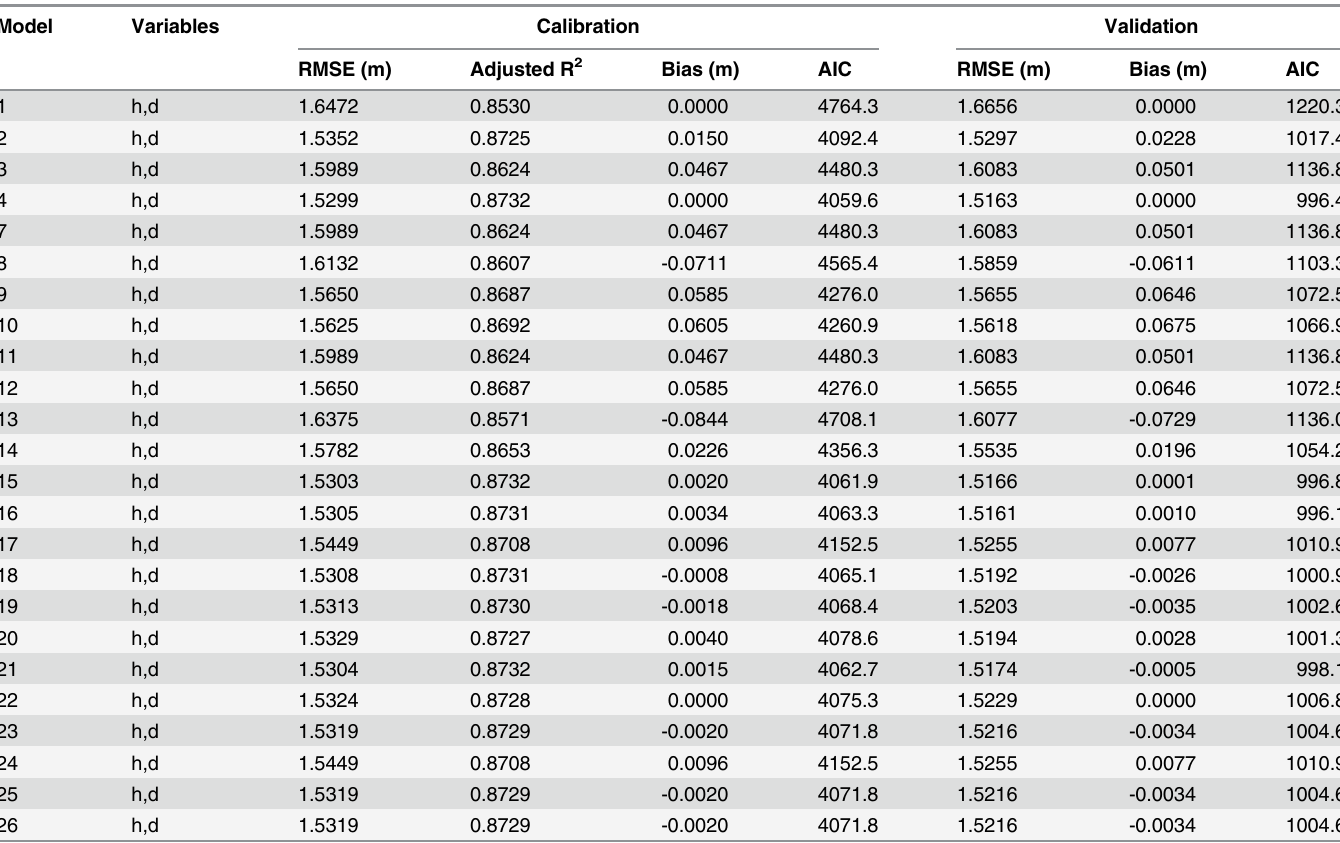
Table 3. Fitting statistics for Group 1 models using both calibration and validation